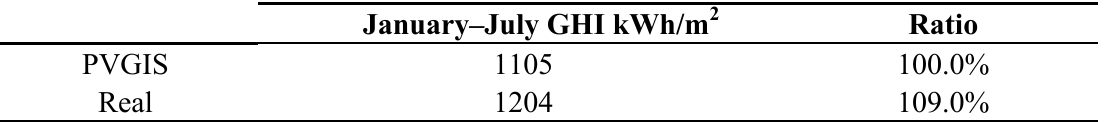
Table 2. January to July PVGIS GHI, real GHI and their ratio for the CPV installation location in 2009.